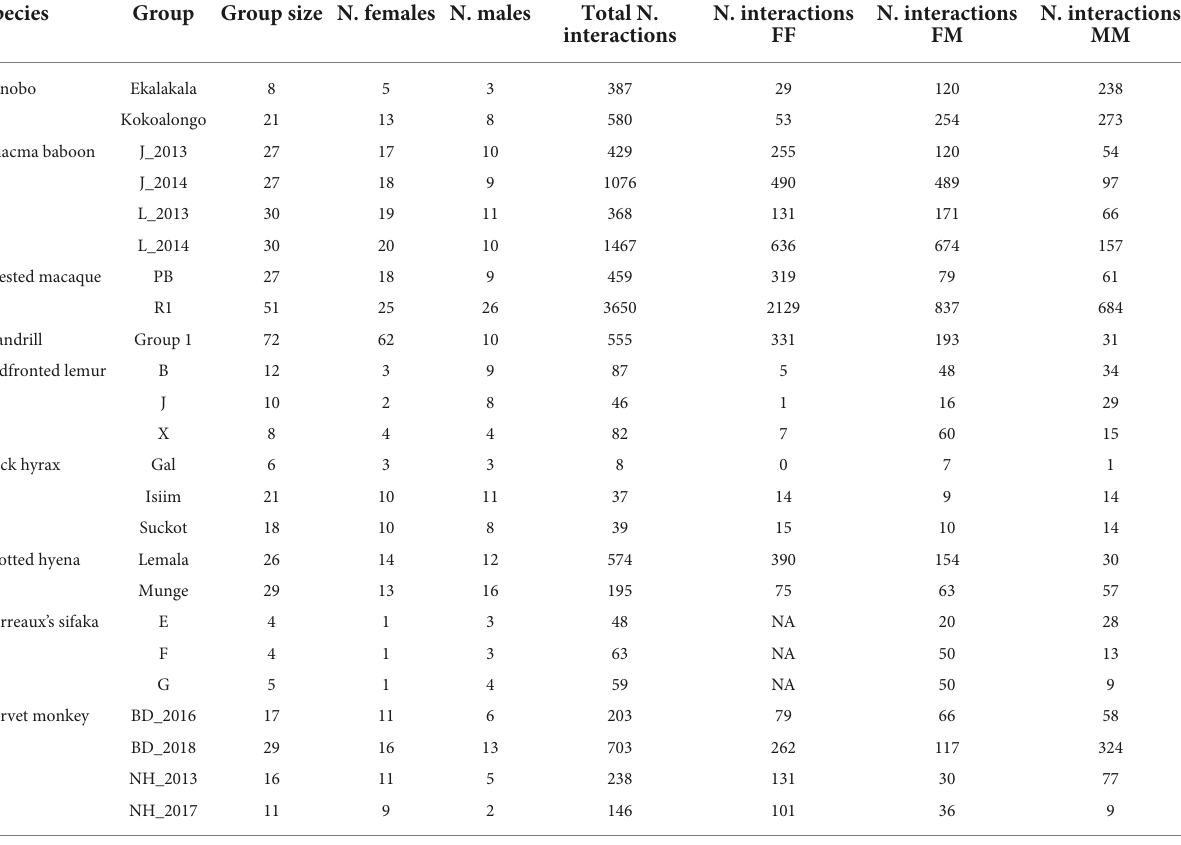
TABLE 1 Summary of the data collated for this study. Species Group Group size N. females N. males Total N.